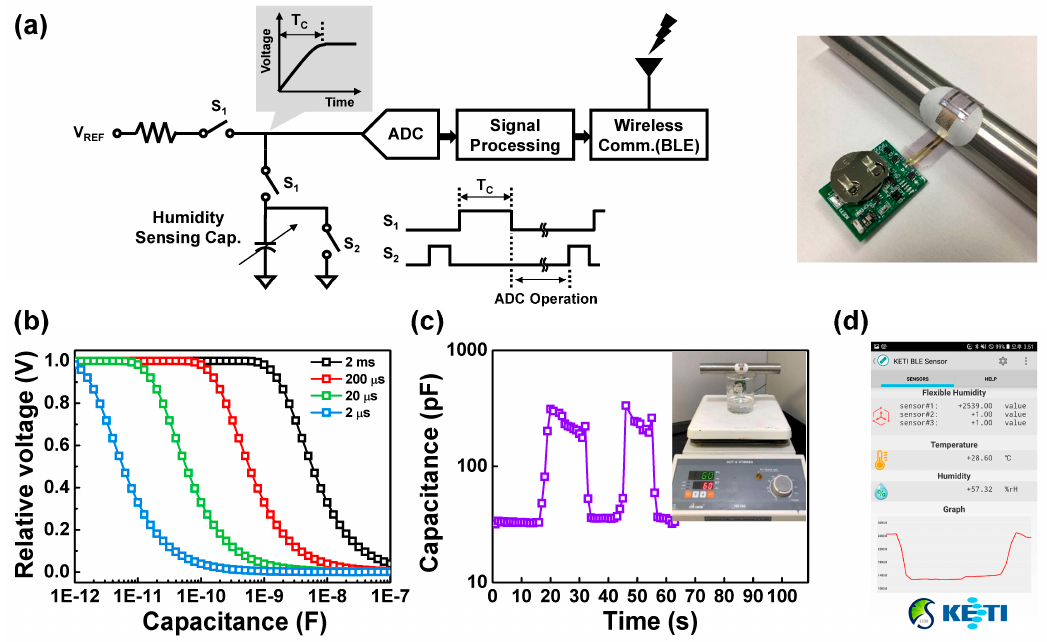
Figure 5. ( a ) Schematic layout of real-time monitoring system containing H-PTFE flexible humidity sensor, readout circuit, Bluetooth module. Inset: real-time monitoring system attached to a curved surface; ( b ) the wide ranges of capacitance at various switching timings (T c = 2, 20, 200, and 2000 μ s); ( c ) real-time monitoring data of water absorptions and evaporations when H-PTFE sensor was attached to a curved surface. Inset: setup condition for testing our real-time monitoring system; ( d ) mobile application.